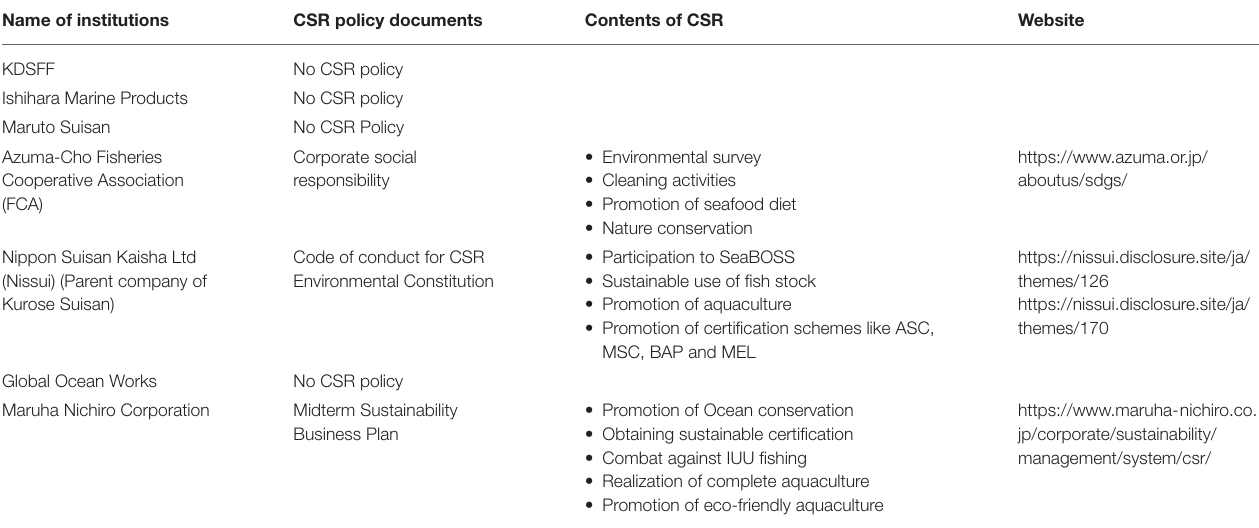
TABLE 5 | Summary of CSR policy of MSC and ASC